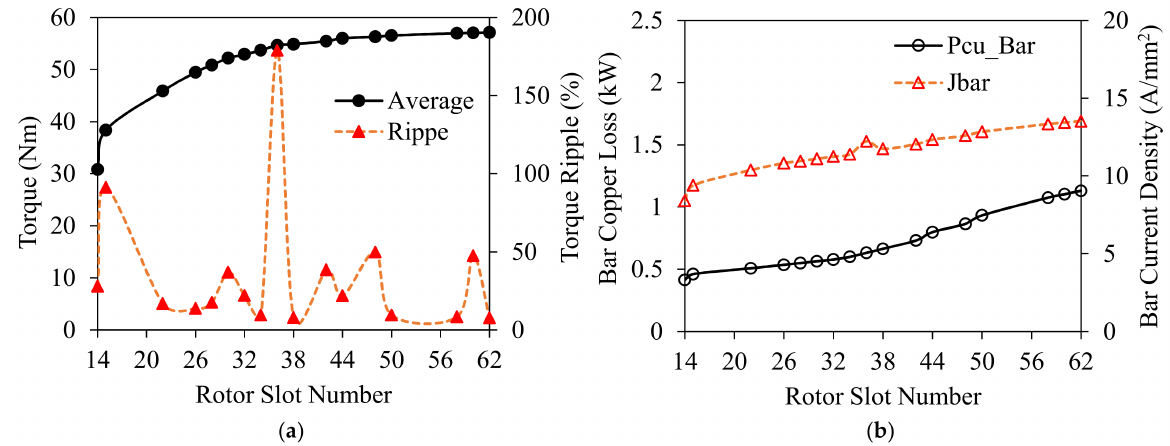
Figure 26. Influence of rotor slot number on the performance characteristics of 36S/12P AIM: ( a ) torque and torque ripple and ( b ) bar copper loss and bar current density.